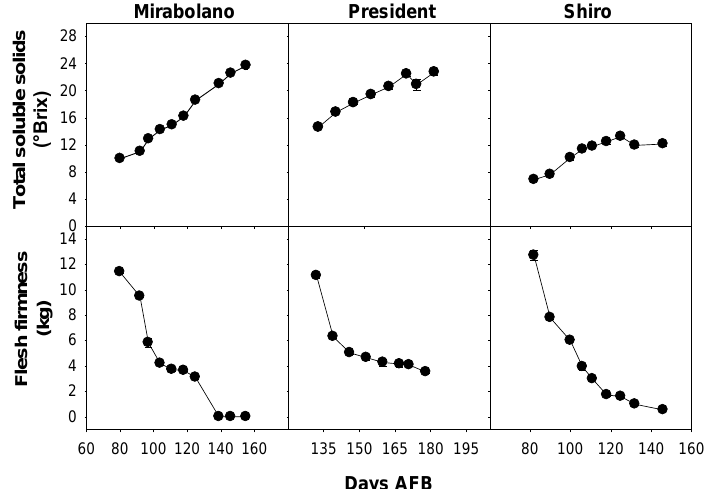
Figure 2. Soluble solids content and flesh (mesocarp) firmness of the flesh (mesocarp + epicarp) of fruits of Prunus cerasifera —Mirabolano, Prunus domestica —cultivar President, and Prunus salicina —cultivar Shiro at different stages of development. Each point on the graph shows the mean and standard error, n = 15. AFB = after full bloom.